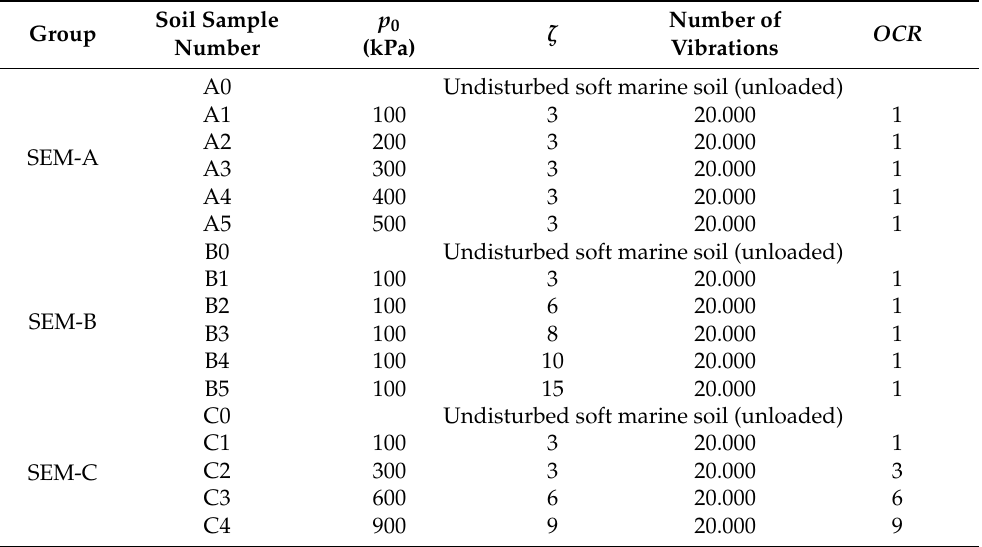
Table 2. Dynamic consolidation compression test and scanning electron microscope test scheme for the undisturbed saturated soft marine